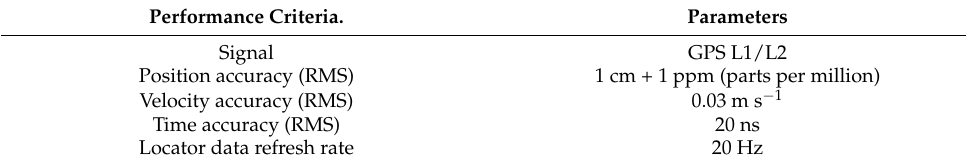
Table 2. Characteristic parameters of the GPS. Performance Criteria.